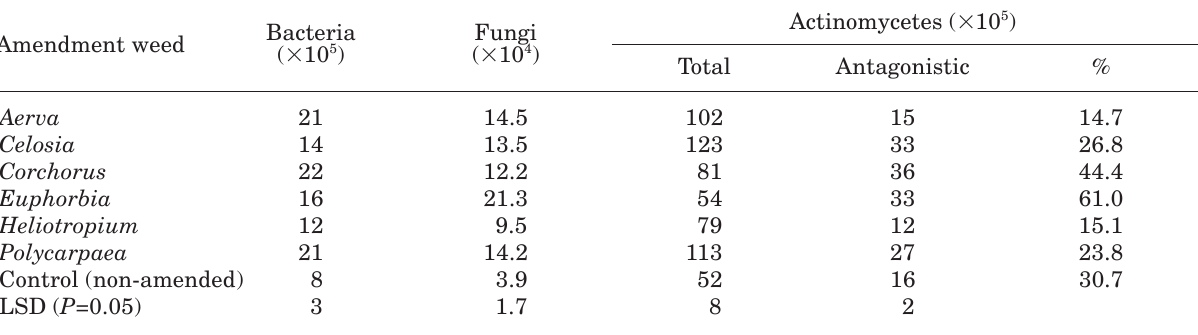
Table 1. Effect of weed residues (1%) on total numbers of bacteria, fungi, actinomycetes and antagonistic actinomyc- etes (g -1 soil) after 90 days of soil incubation at 28±2°C under laboratory conditions. Bacteria